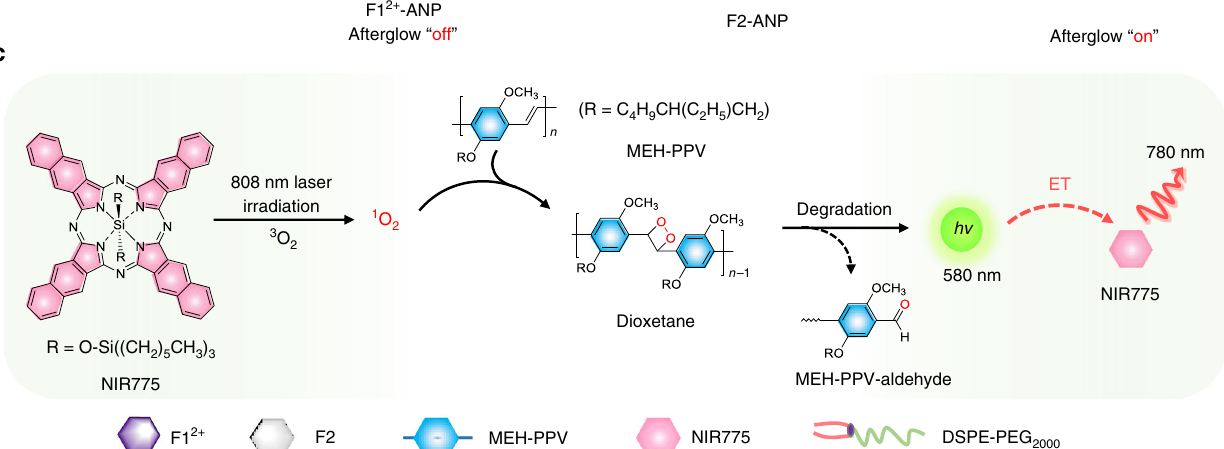
( − 8.1 eV) than 1 2 + ( − 7.8 eV), which was validated by cyclic voltammetry (CV) analysis (Supplementary Fig. 1c). The E red of F1 2 + ( + 0.40 V vs. SCE) was higher than that of 1 2 + ( + 0.25 V vs. SCE), suggesting that F1 2 + could act as a stronger oxidant toward H 2 S. High-performance liquid chromatography (HPLC) analysis showed that purple F1 2 + could be ef fi ciently reduced into light yellow diene F2 by NaHS (H 2 S donor) in phosphate-buffered saline (PBS) buffer (pH 7.4), resulting in a noticeable blue shift of UV – visible – NIR absorption from 550 and 758 nm to 430 nm (Supplementary Fig. 2b, c). The second-order reaction rate ( k 2 ) between F1 2 + and NaHS in PBS buffer (pH 7.4) was found to be 3600 ± 130 M − 1 s − 1 , ~11.8-fold faster than that of